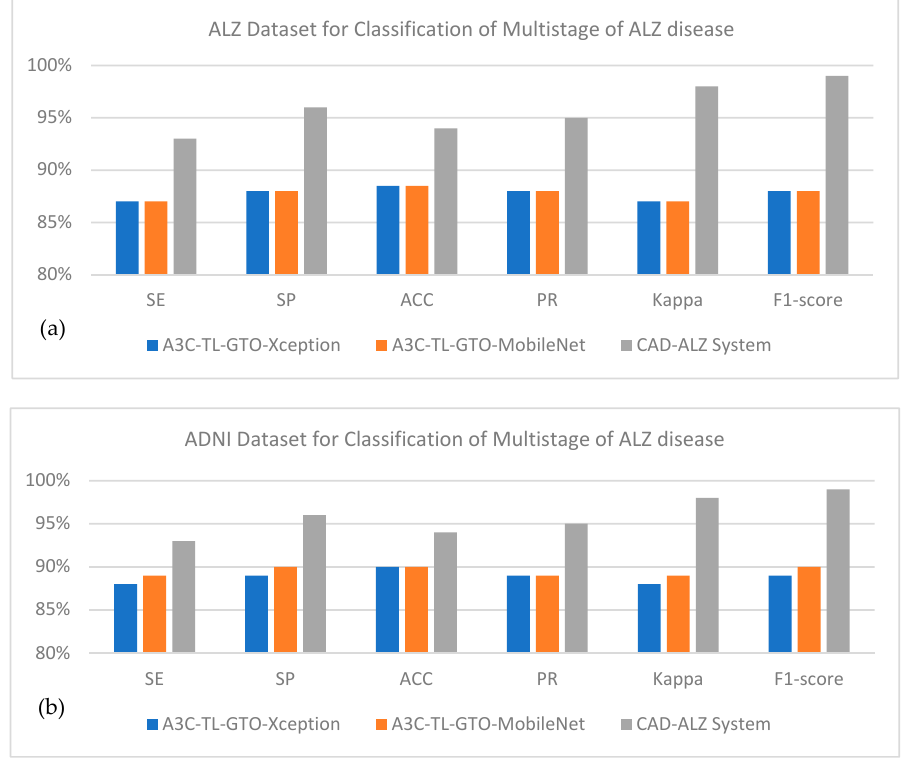
Figure 9. Comparisons by using ( a ) ALZ and ( b ) ADNI datasets by using state-of-the-art systems to recognize four stages of AD, such as non-demented, mild dementia, moderate dementia, and very mild dementia.